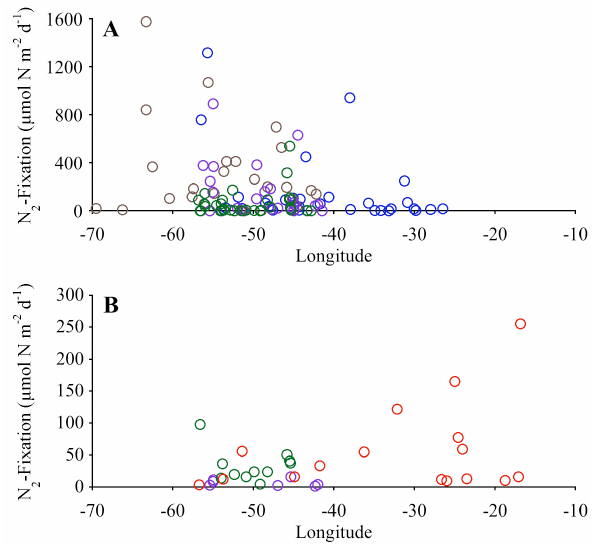
Fig. 5. Areal N 2 fixation rate as a function of longitude for Tri- chodesmium (A) and whole water incubations (B) . Colors as in Figure 5. Areal N 2 fixation rate as a function of longitude for Trichodesmium (A) and whole Fig. water incubations (B). Colors as in Fig. 1.